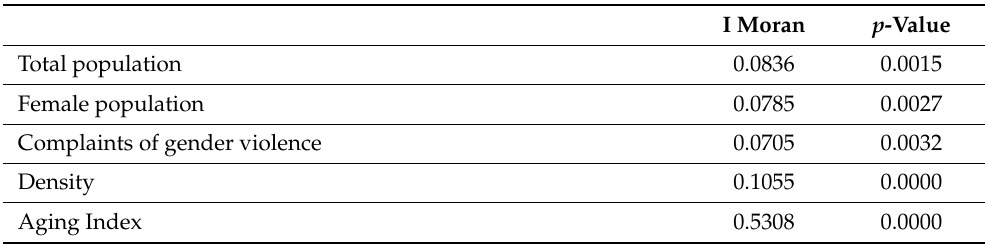
Table 3. ROWVGV . Rate of Women over 64 years of age who are victims of Gender Violence by their current or previous partner throughout their lives ( ROWVGV ). Sources: own elaboration